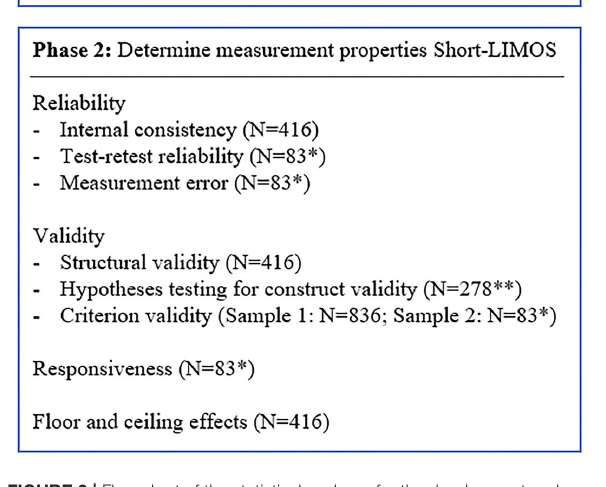
FIGURE 2 | Flow chart of the statistical analyses for the development and validation phase. *Patients transferred from acute stroke unit to neurorehabilitation within 1–4 days; **Short-LIMOS total score and Barthel Index total score at admission acute stroke